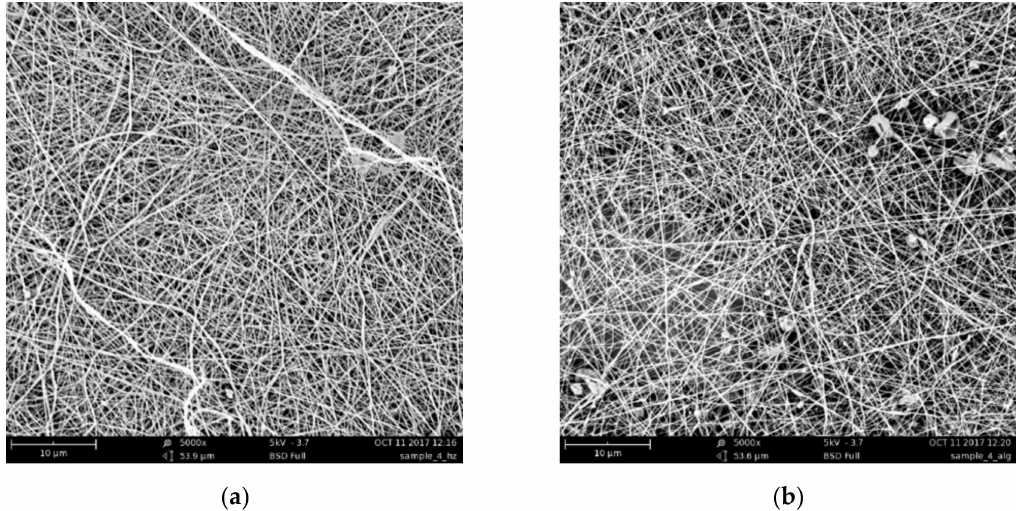
Figure 2. SEM images of the CS surface ( a ) and the ALG&CNW surface ( b ) of the bilayer CS–ALG&CNW sca ff old.